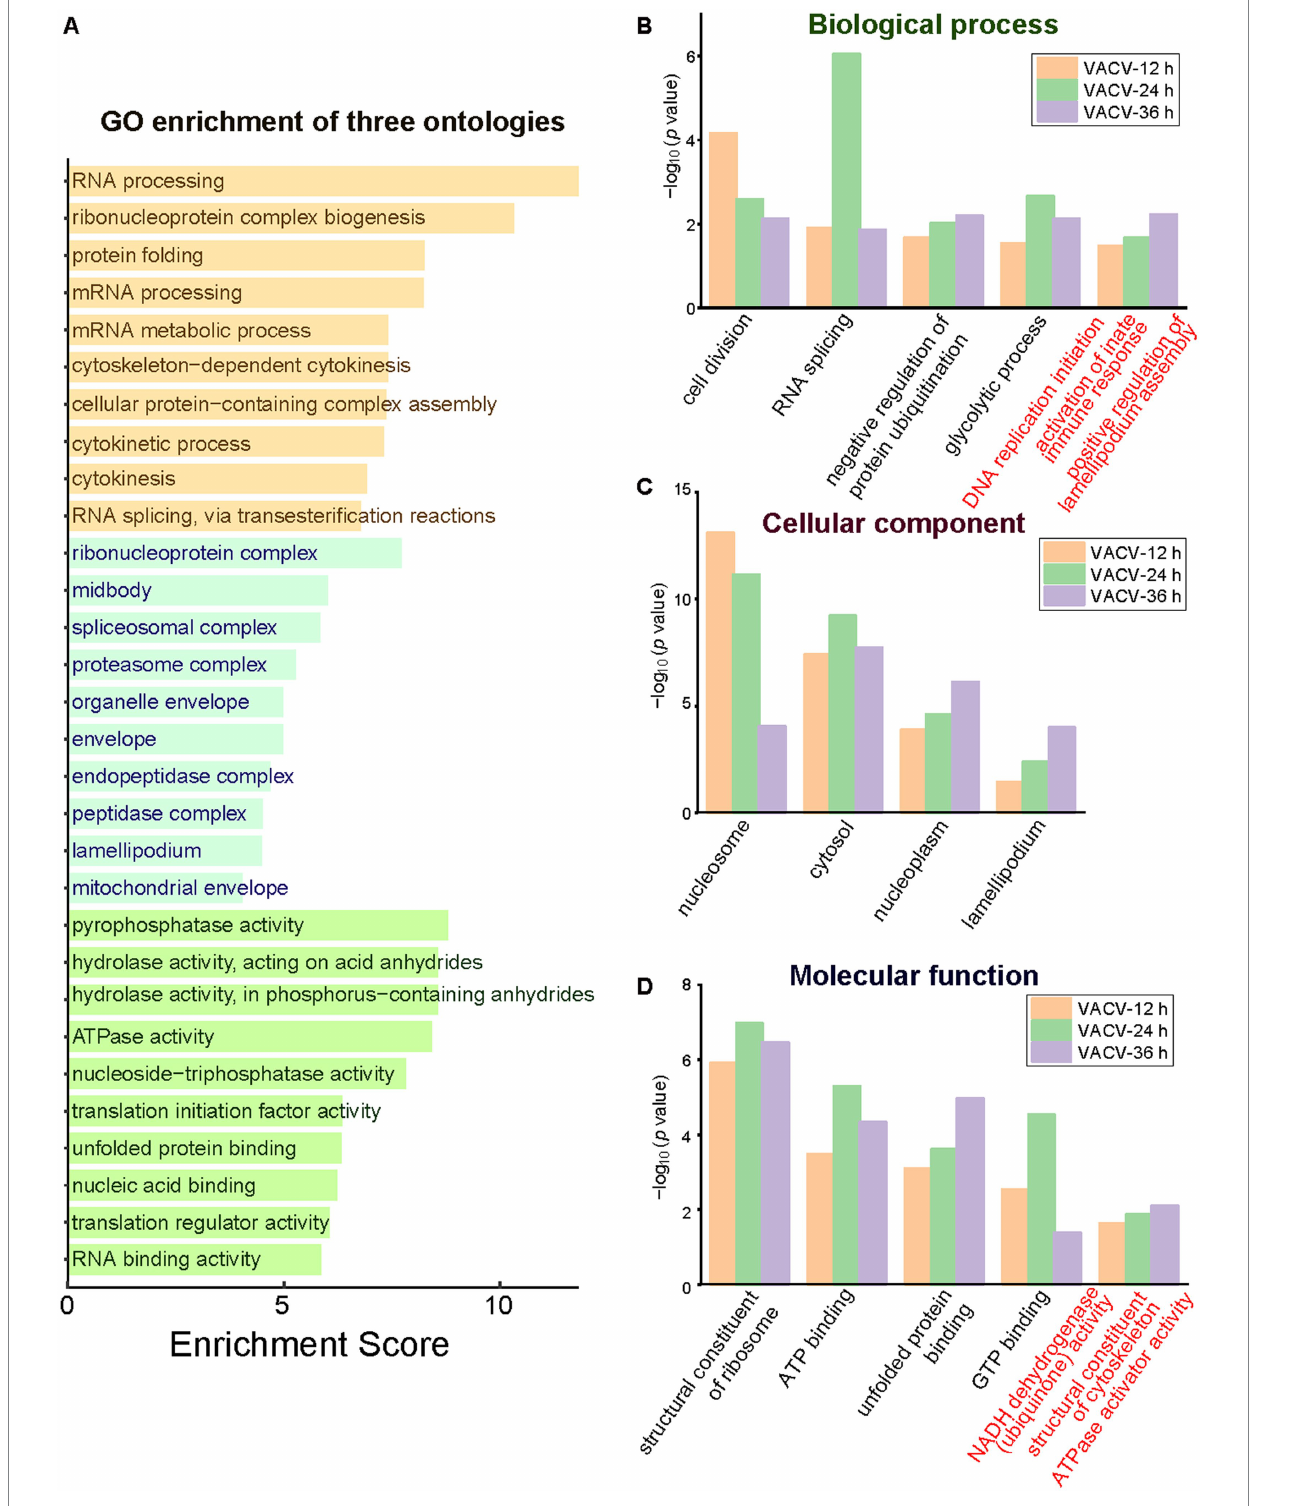
FIGURE 5 The GO enrichment of three ontologies at multiple time points of infection. (A) The holistic bar chart of the top 10 enriched terms in each ontology. The bar chart of GO enrichment in biological process (B) , cellular component (C) , and molecular function (D) at different time points of infection. Distinguished terms of each ontology are marked in